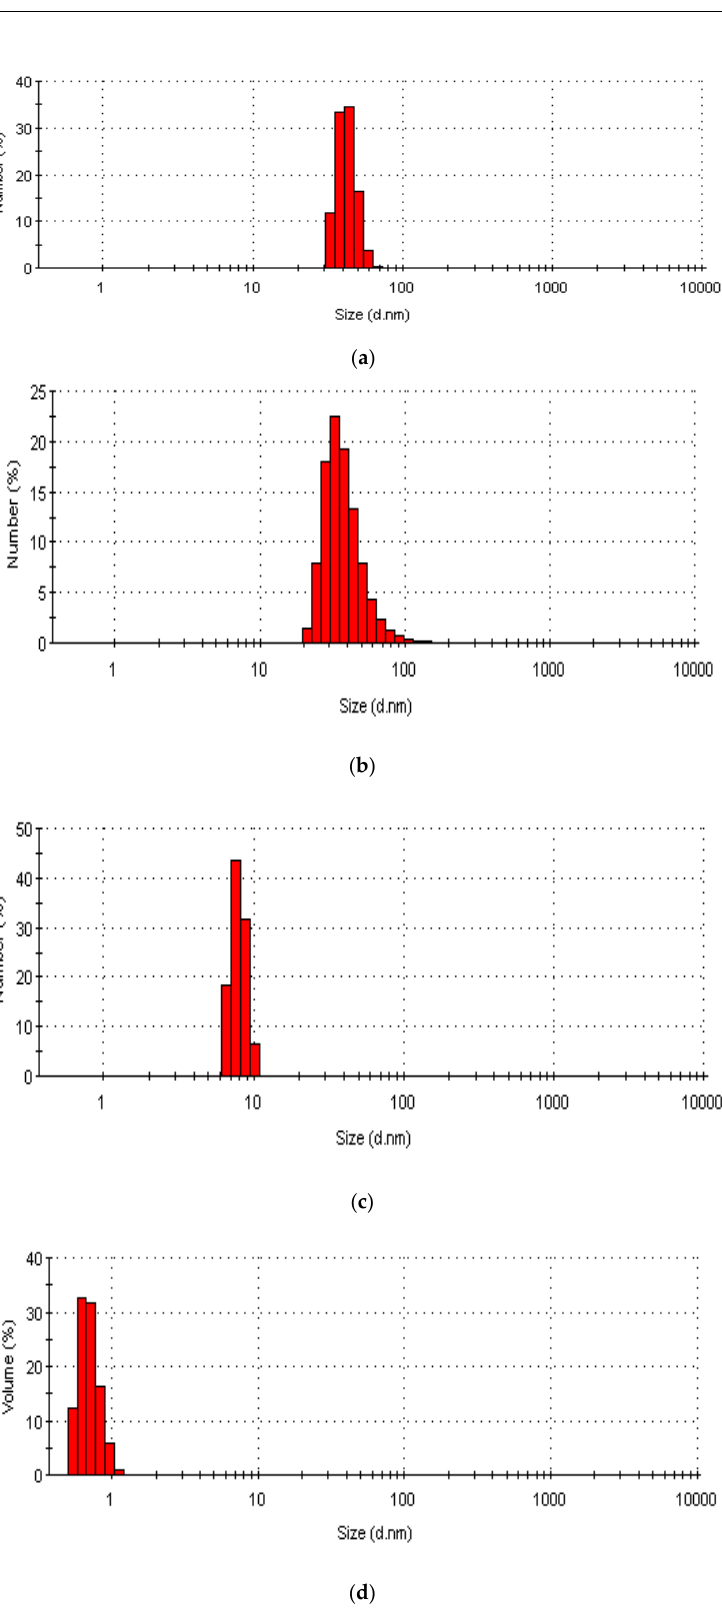
Figure 5. DLS particles and size distribution of rGO/CuO composites at ( a ) 0.125 wt.% rGO, ( b ) 0.250 wt.% rGO, ( c ) 0.50 wt.% rGO, and ( d ) 1.0 wt.%